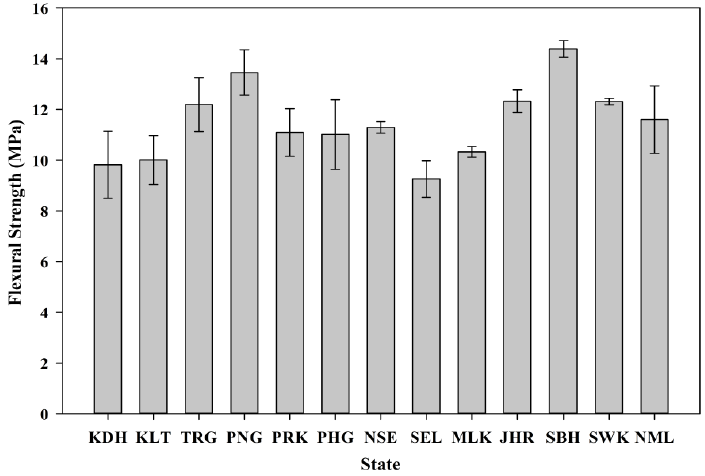
Figure 15. Flexural strength results for all states.